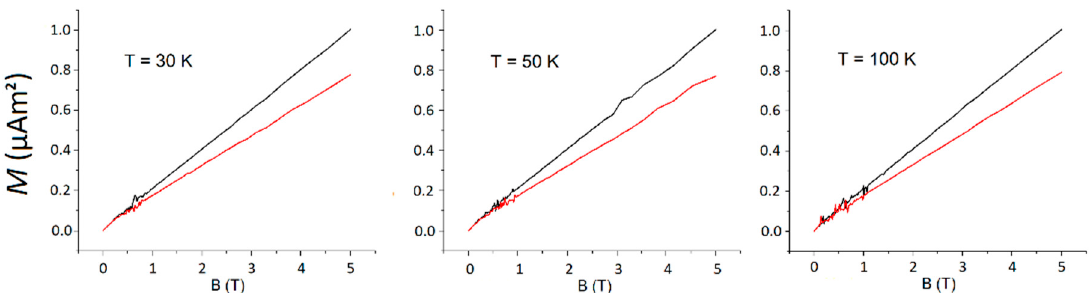
Figure 8. The measured virgin curves of [V(L sq1 )(HL ox )] on a SrTiO 3 disk. The red curves result from the measurements done under irradiation in the NIR region, and the black curves are from the measurements done without irradiation.